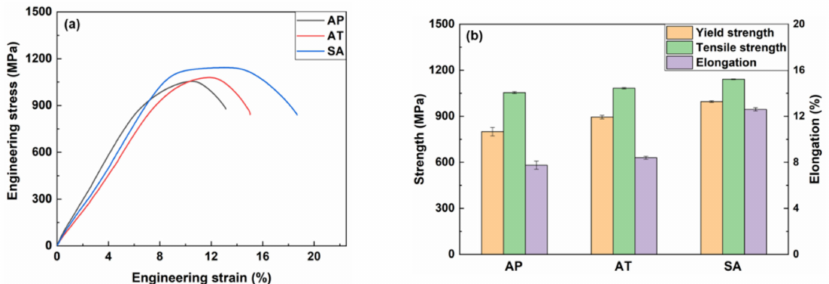
Figure 7. ( a ) Engineering stress-strain curves; and ( b ) the corresponding yield strength, tensile strength and elongation values of AP, AT and SA samples.